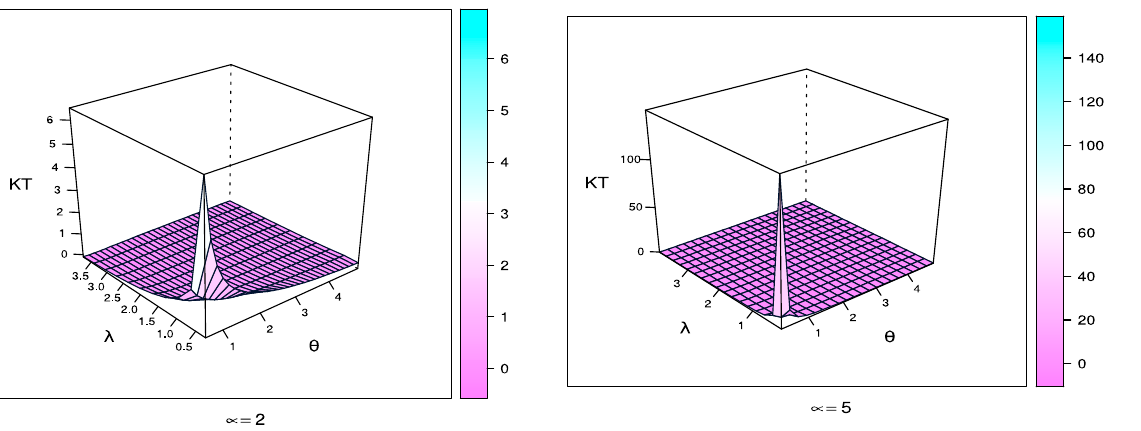
Figure 5. Kurtosis plot for TCPWE distribution with different values of parameters when ρ = 2 and ρ = 5 .